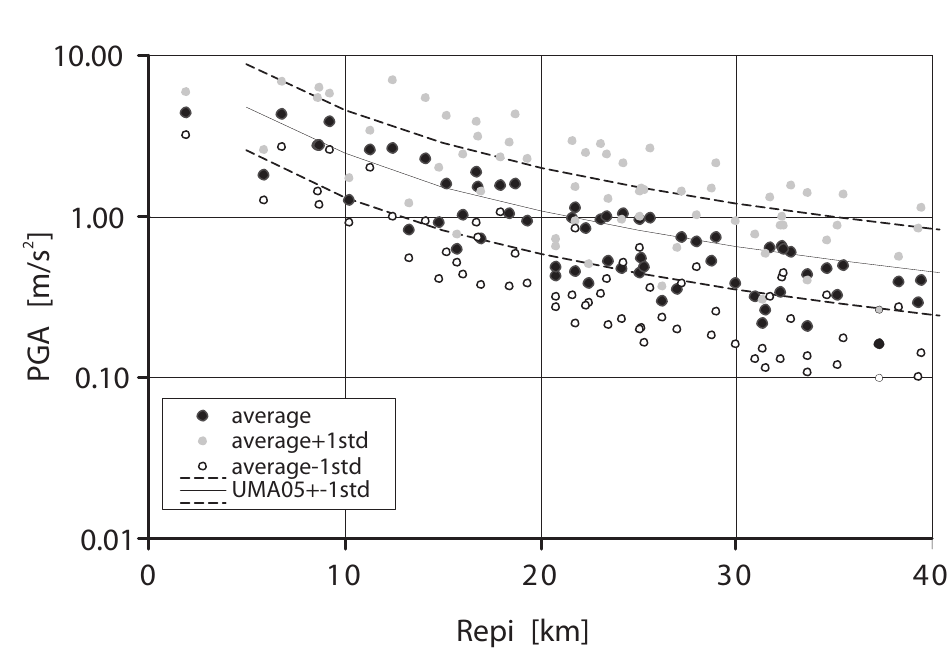
Fig. 7. Average PGA with ± one standard deviation of the computed scenarios compared with UMA2005 ground motion prediction equation (Bindi et al. ,